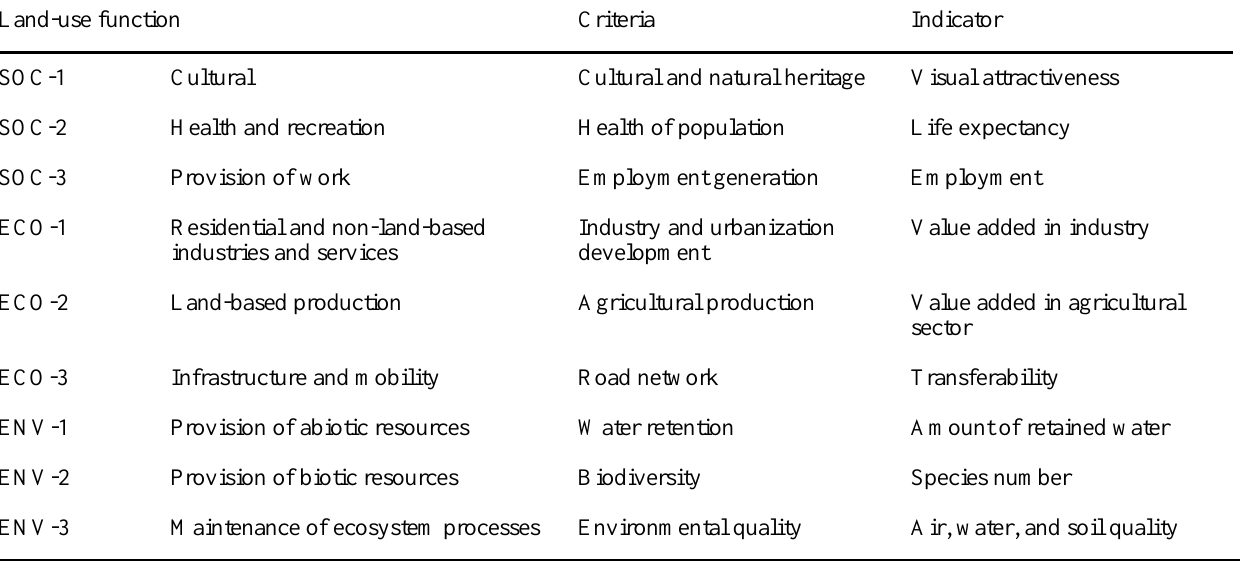
Table 2 . Land-use functions and indicators used by stakeholders for impact assessment of scenarios and sustainability